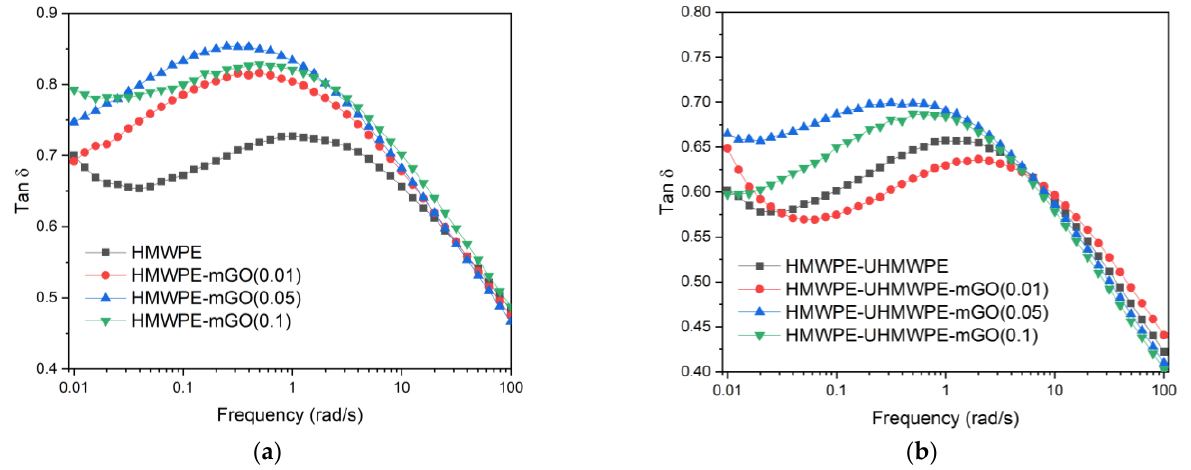
Figure 3. Loss factor tan δ of the HMWPE and its nanocomposites ( a ) and HMWPE-UHMWPE (80/20 wt.%) and its nanocomposites ( b ) obtained from the rheological test.